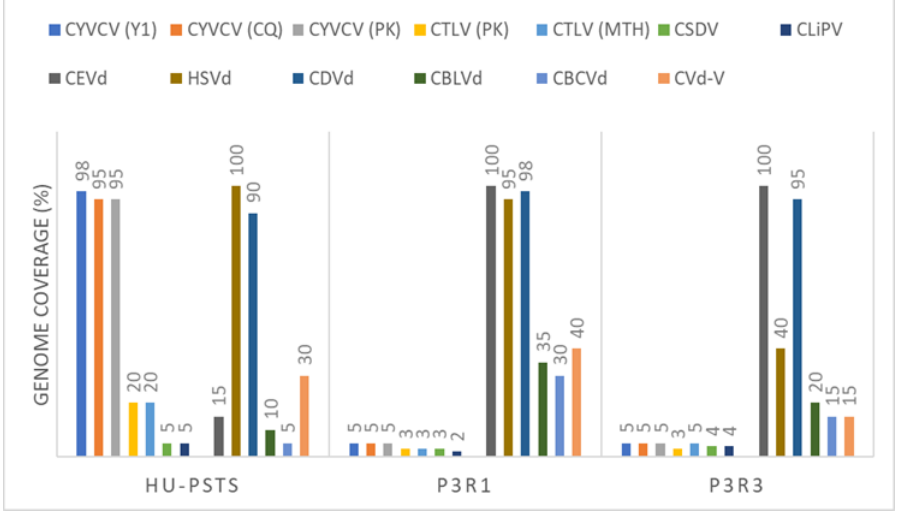
Figure 5. Graphical illustration of genome coverage per representative genome reference of non- EU viruses and viroids after read mapping the siRNA library of each sample individually.